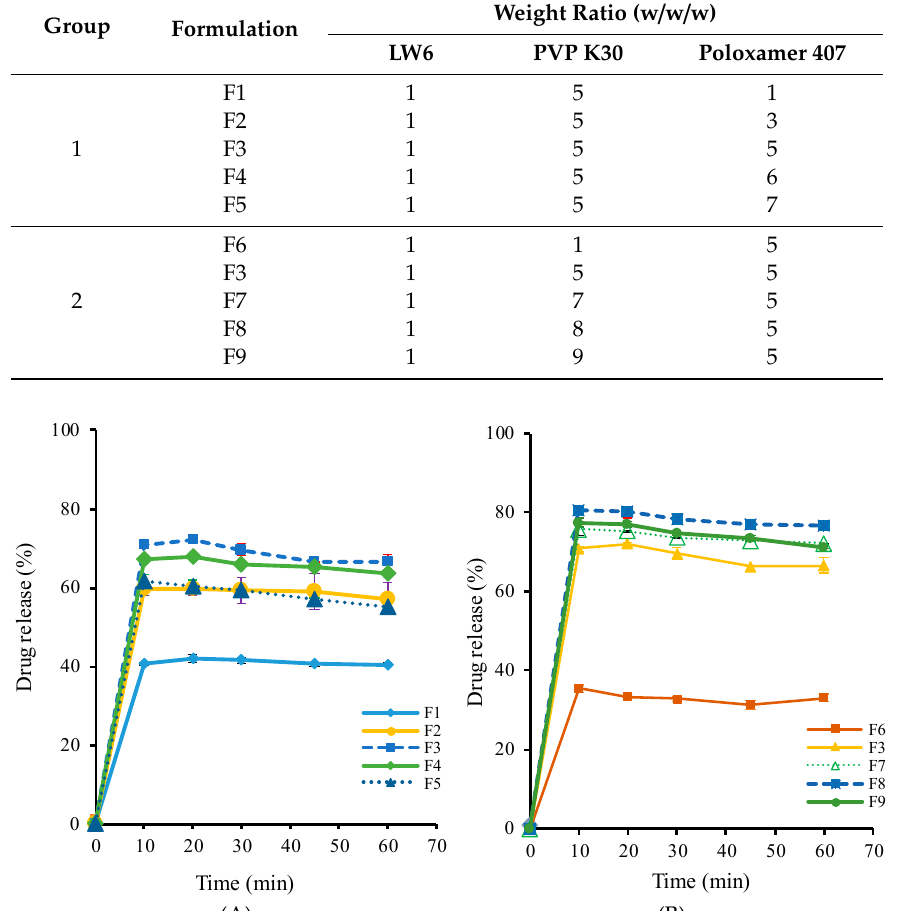
Figure 5. Drug release profiles of various SD formulations in water. Data are expressed as the mean ± standard deviation (n = 3). ( A ) Effect of poloxamer 407; ( B ) Effect of PVP K30.